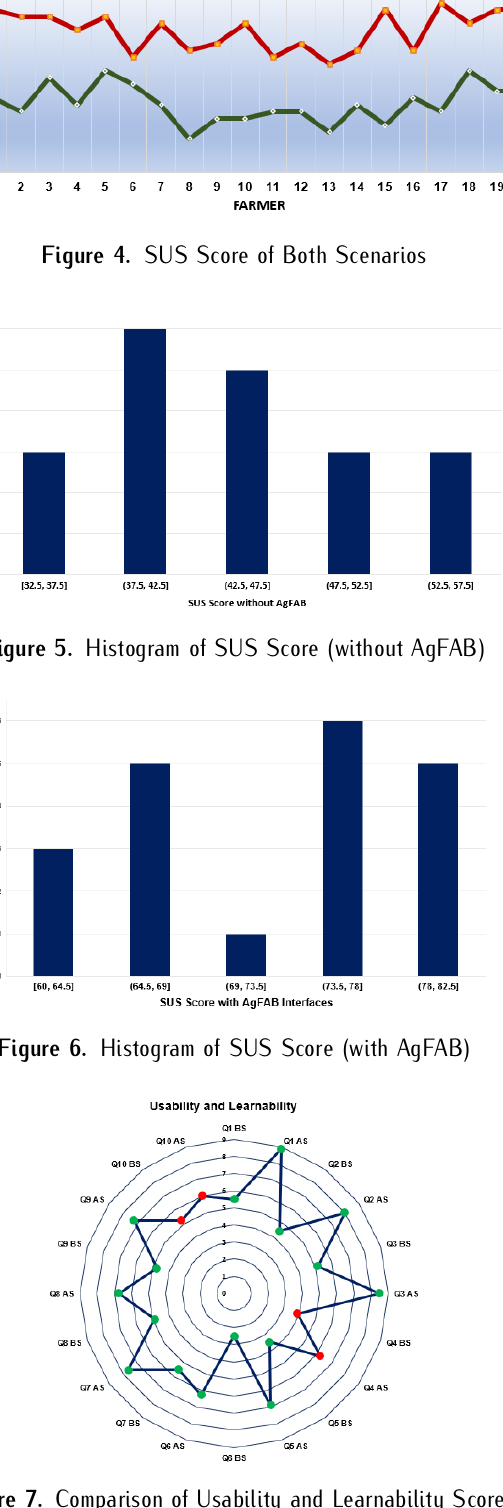
Figure 7. Comparison of Usability and Learnability